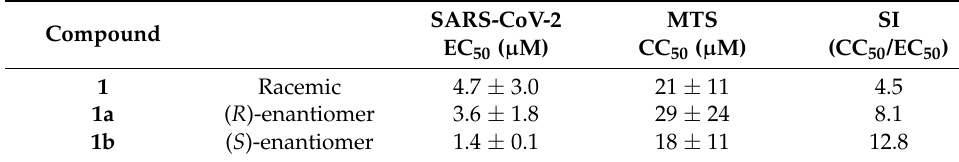
Table 1. Antiviral activity and cytotoxicity of racemic 1 and its enantiomers 1a and 1b .